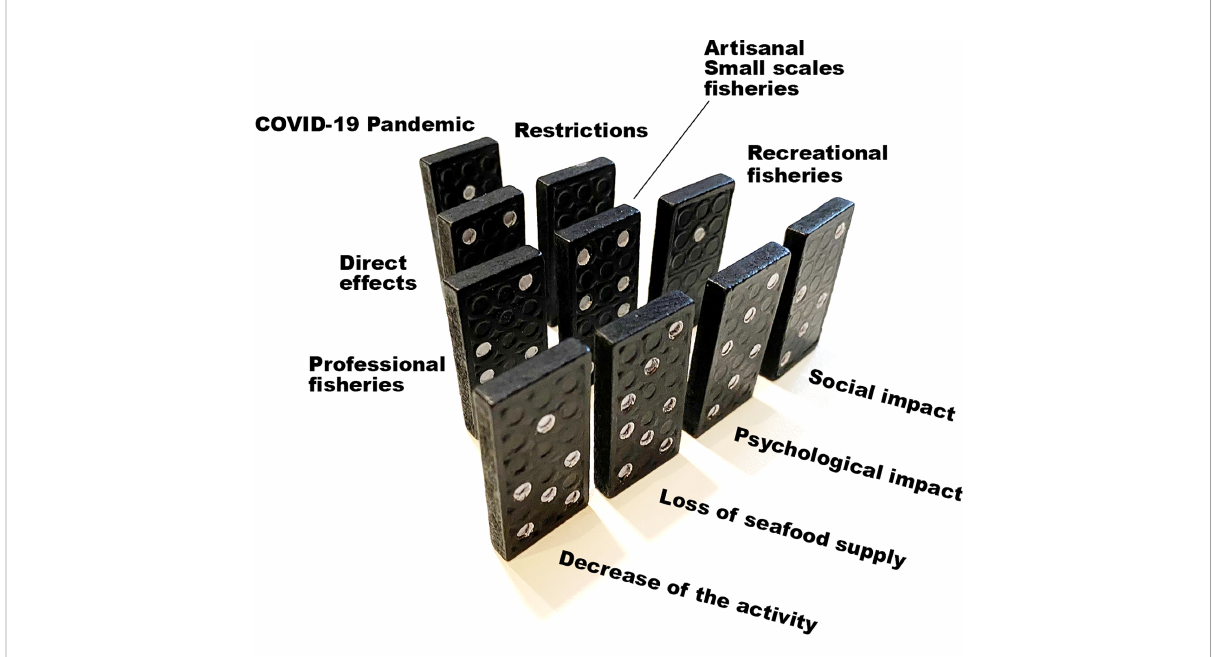
FIGURE 1 Representation of the domino effect triggered by the COVID-19 pandemic and affecting fi rst all fi sheries sectors and then, progressively, the food chain and the economic and social communities associated with fi